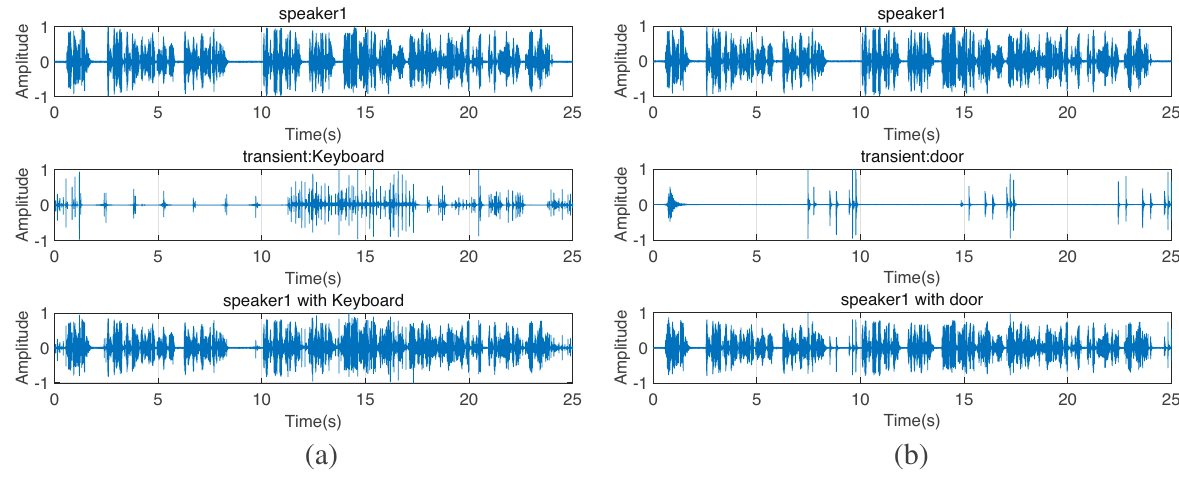
Fig. 7 The waveform of speech signal contaminated with door knocking and keyboard